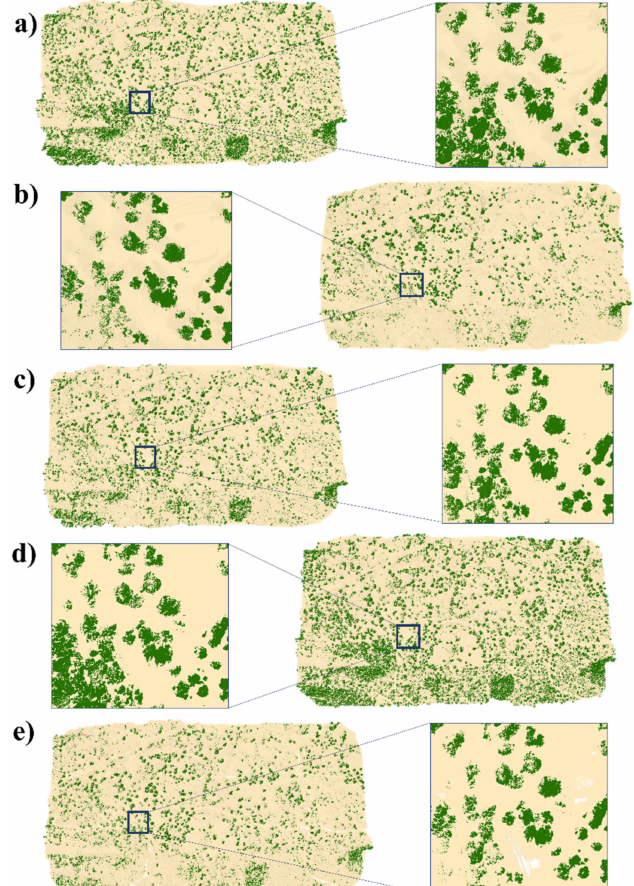
Figure 13. VIs classified models: ( a ) NDVI; ( b ) NDRE; ( c ) GNDVI; ( d ) MCARI2; ( e ) RDVI2.